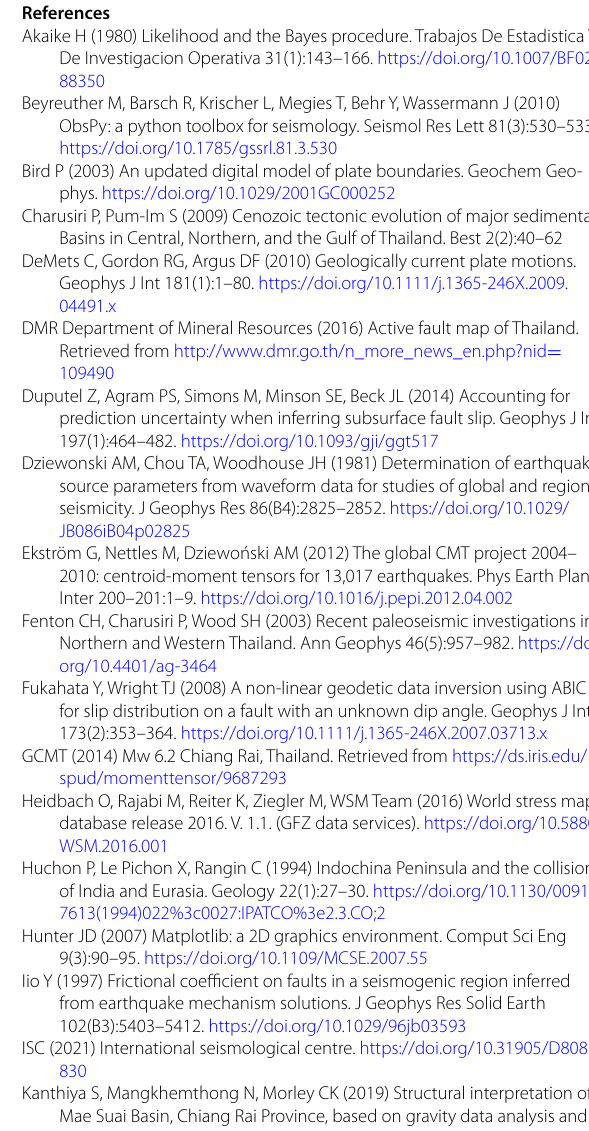
rupture propagating toward NE along Fault 2. Figure S10. Summary of the numerical test of one input rupture fault of the Fault 1. Figure S11. The summary of the sensitivity test of the different model plane depth at 4 km, 5 km, and 6 km. Figure S12. The summary of the reproduction test. Figure S13. The summary of a single vertical fault plane analysis. Figure S14. The waveform fit between the observed waveform and the synthetic waveform of our study, an assumed horizontal plane covering only on the N-S analysis in Additional file 1: Fig. S15, and a single vertical mode plane analysis in Additional file 1: Fig. S13. Figure S15. The summary of the analysis assuming a horizontal model plane covering only the N-S segment. Table S1. Velocity structure (Wongwai et al. 2013) used for cal- culating Green’s function. Table S2. Velocity structure used for calculating Green’s function made from CRUST1.0 model (Laske et al.